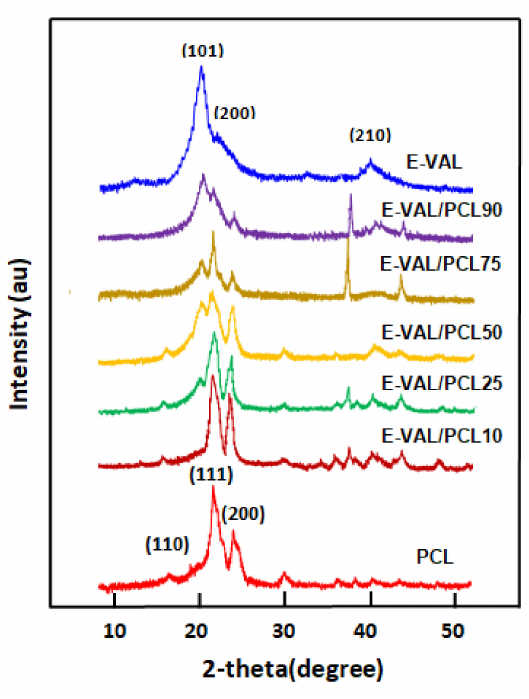
Figure 7. X-ray diffractograms of E-VAL, PCL, and their blends with different